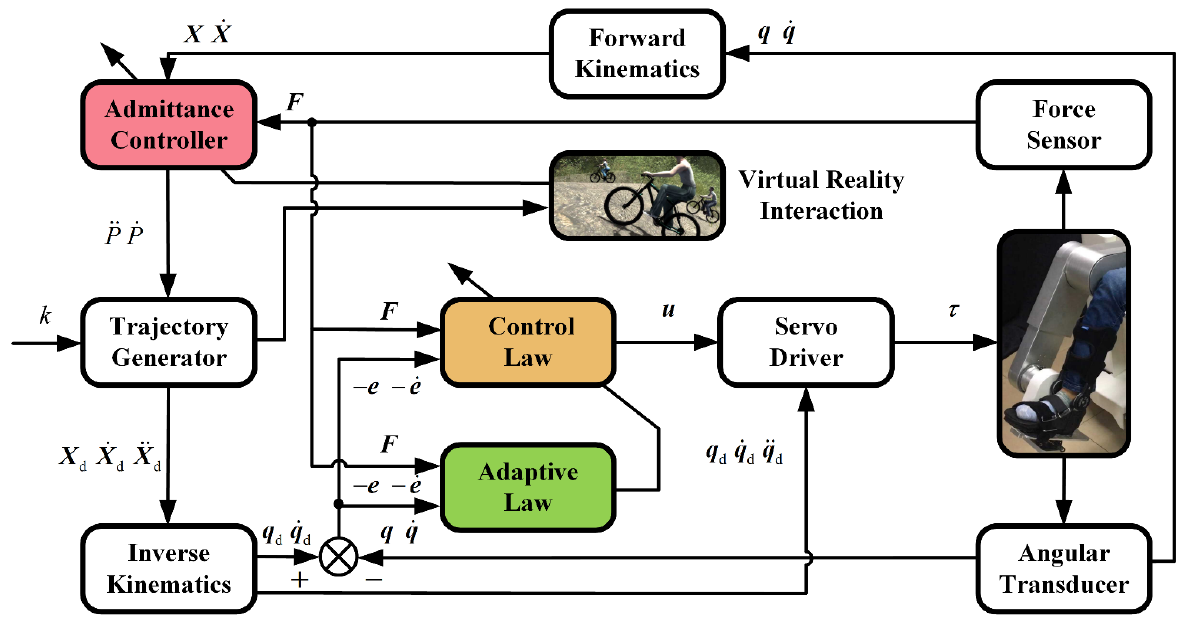
. ..  X , and  X represent X , X d , and X d represent the d d d . ..  q , and  q are desired position, velocity, and q , q q , and are desired position, velocity, and acceleration d d d d d .. . . . . − e = q q and −    e = q q represent the position and velocity joint errors. P  and P  e = q − q P and P are the acceleration represent the position and velocity joint errors. d d d